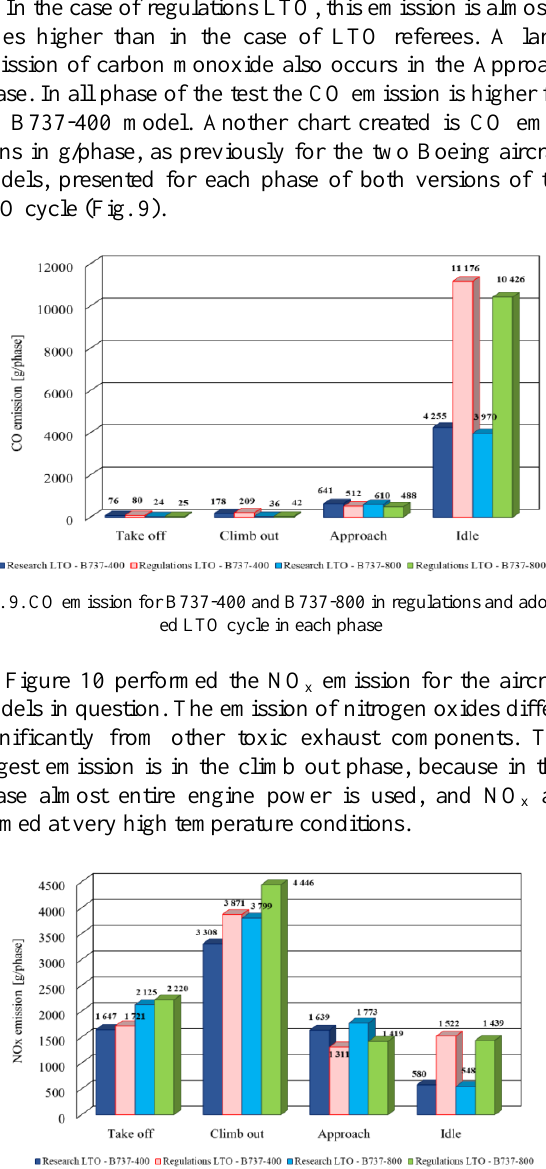
Fig. 10. NO x emission for B737-400 and B737-800 in regulations and adopted LTO cycle in each phase